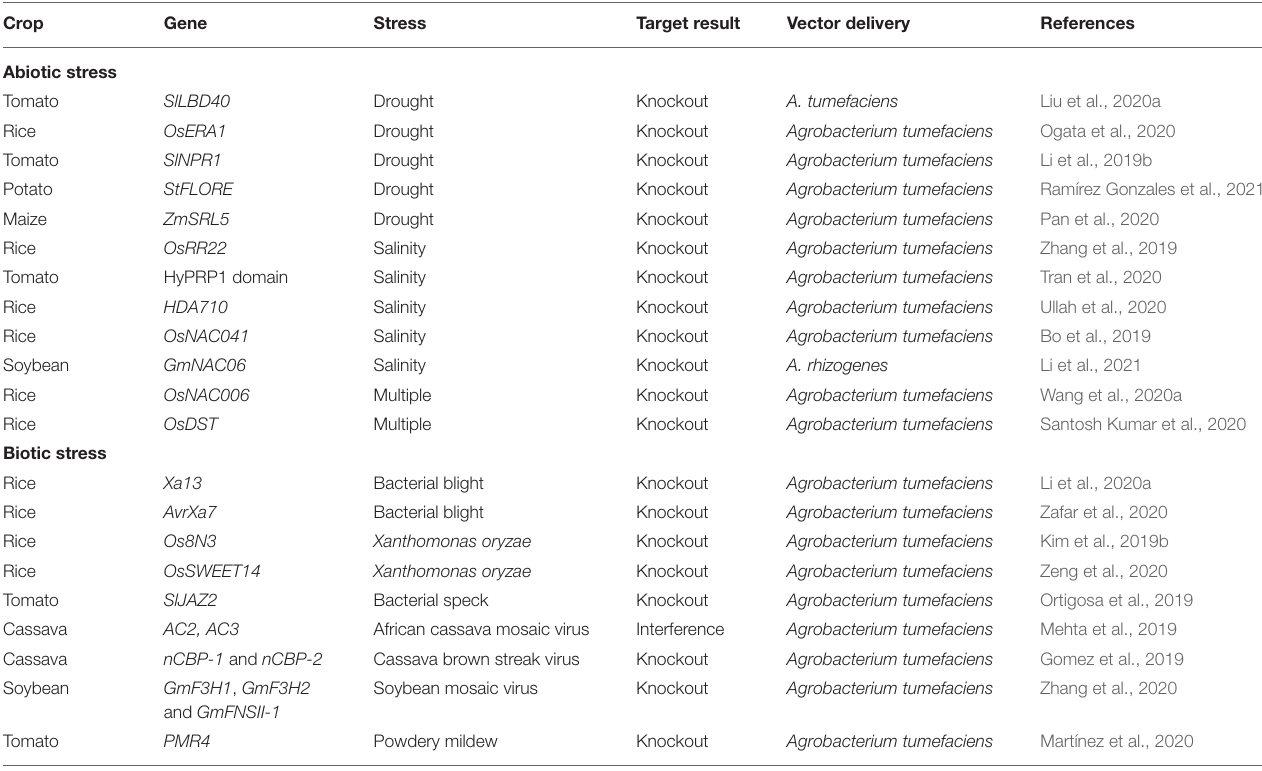
TABLE 4 | Applications of clustered regularly interspaced short palindromic repeat/CRISPR-associated (CRISPR/Cas) system to engineered abiotic/biotic stress tolerance.